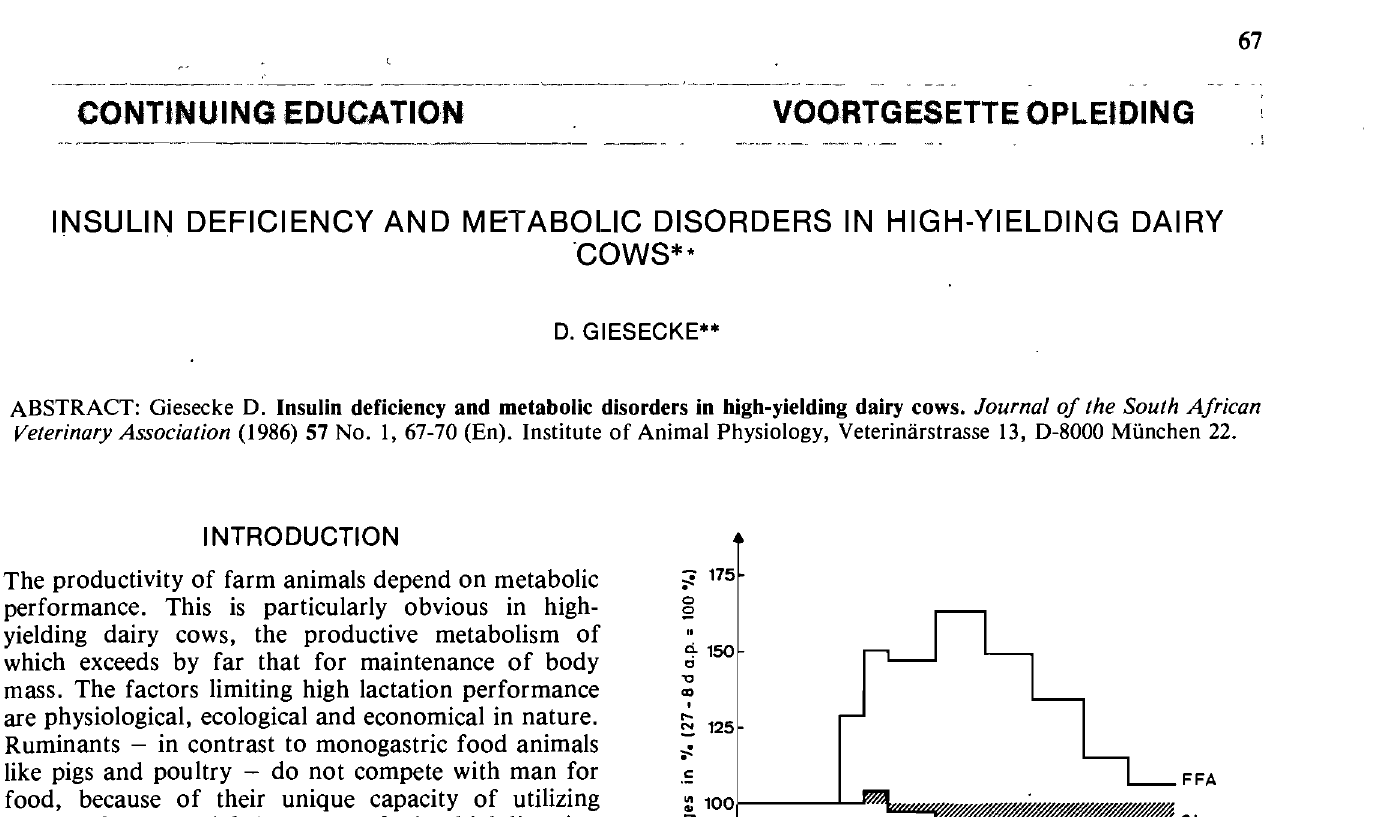
Fig. 1: Changes (in %) of plasma glucose and free fatty acids (FFA) in cows (n = 6) before (a.p.) and after parturition (0),